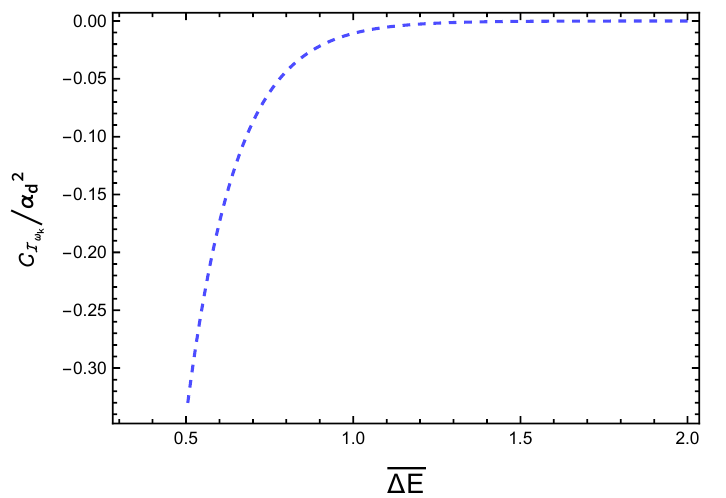
, signifying the concurrence, is plotted for two outgoing null Figure 14 . The quantity C I /α 2 d ωk detectors in a (1 + 1) dimensional de Sitter spacetime with respect to the dimensionless transition energy ∆ E of the detectors for fixed dimensionless frequency of the field ω d/α d = 0 .